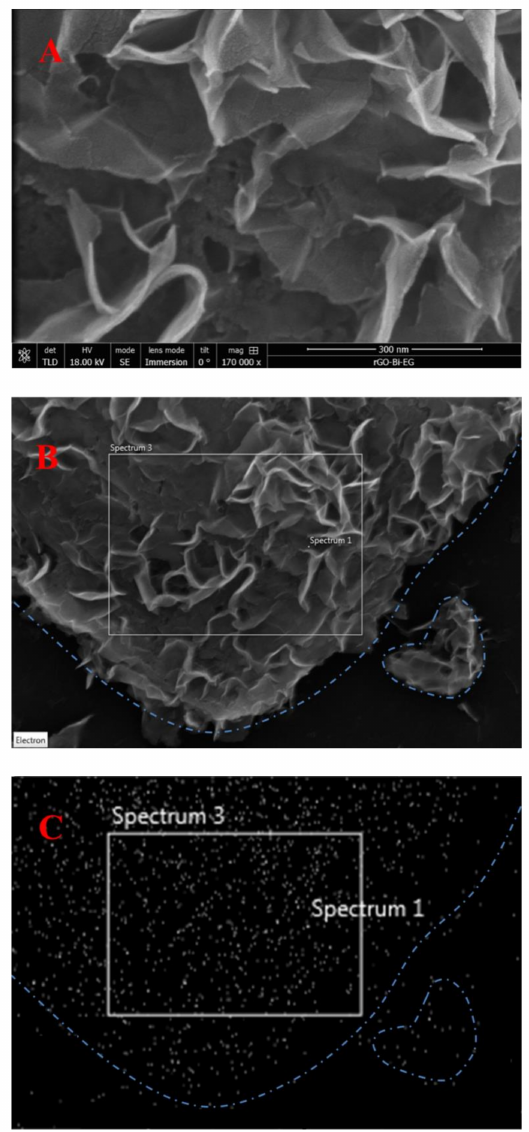
Figure 3. Scanning electron microscopy (SEM) of (BiO) 2 CO 3 -rGO ( A ) and energy-dispersive X-ray spectroscopy (EDX) mapping of Bi ( B , C ). The distribution density of Bi in micrograph ( B ) matches the distribution density of rGO nanosheets in micrograph ( C